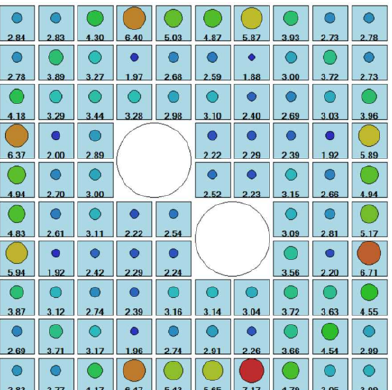
Figure 1: ABWR end-of-life Rod Internal Pressure (RIP) map in units of MPa, within the assembly with the highest RIP at